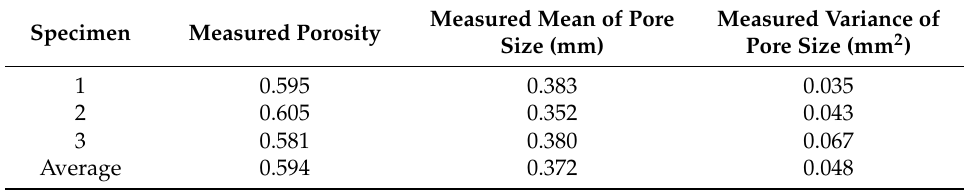
Table 6. Measured porosity, mean of the pore size, and the variance of the pore size of the printed specimens.